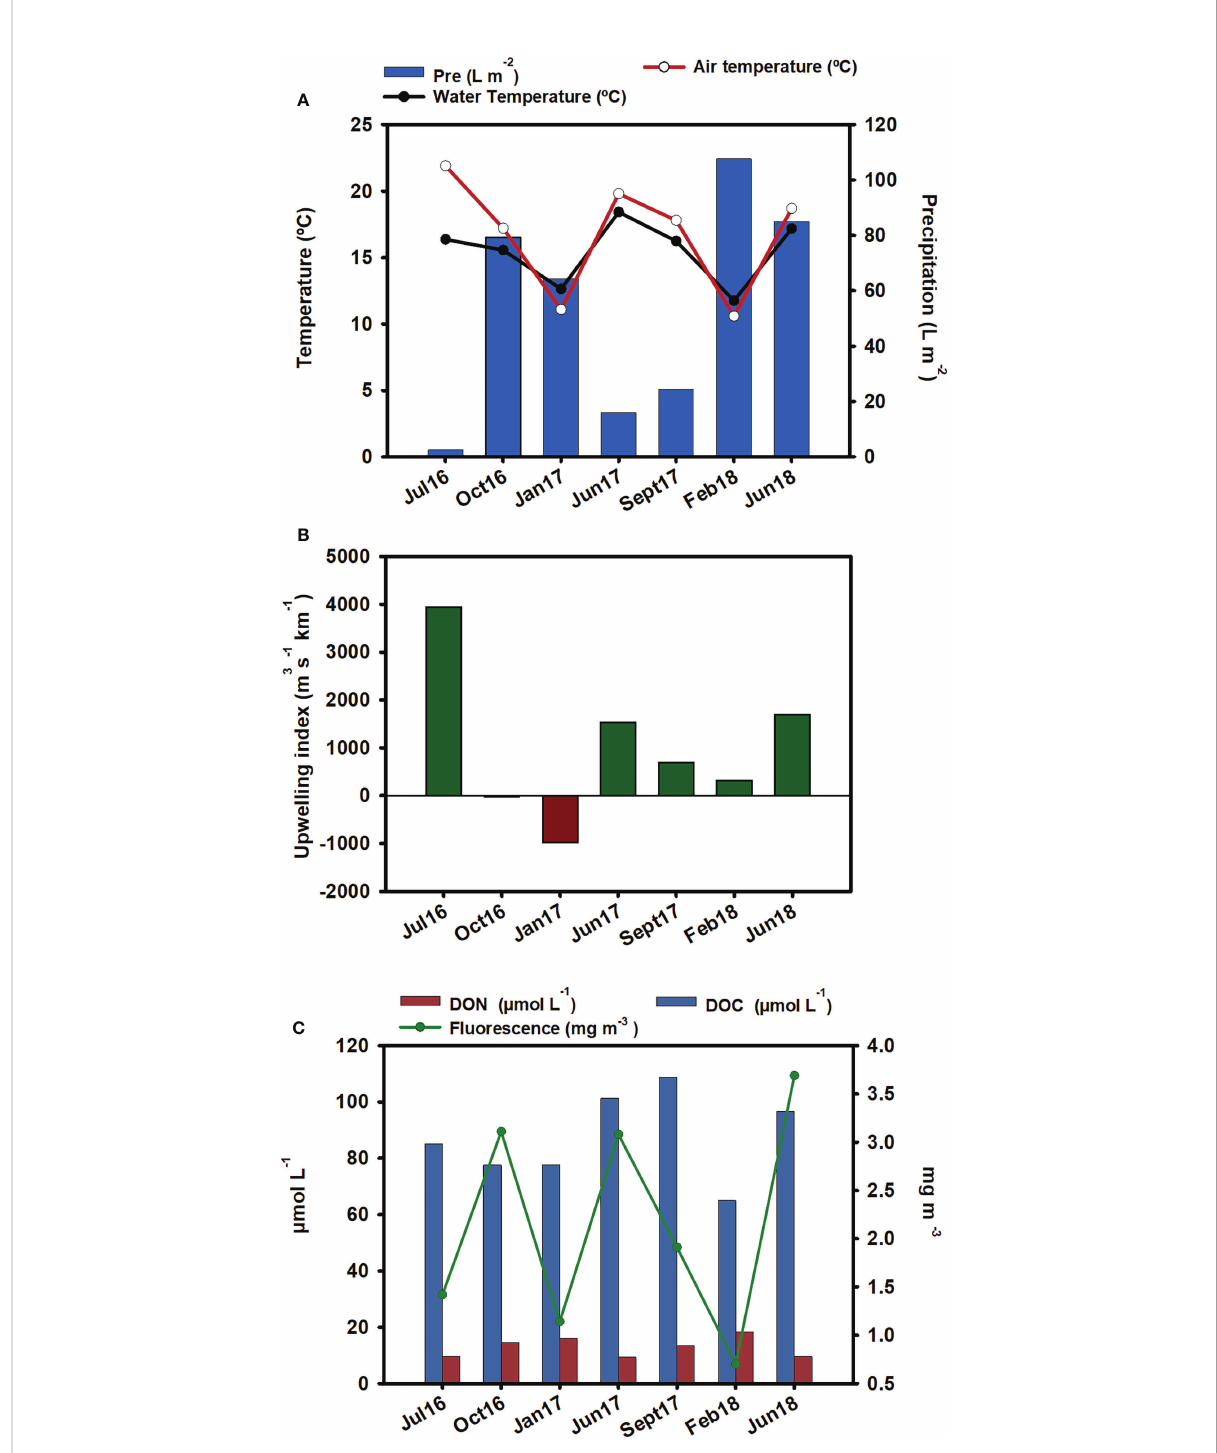
FIGURE 2 Environmental parameters: (A) precipitation (L m -2 ), water temperature (°C), and air temperature (°C). Data source: Meteogalicia (B) upwelling index. Data source: IEO. (C) DOC (µmol-L -1 ), DON (µmol-L -1 ), and fl uorescence (mg m -3 ) from the nearest station (V2 Moaña) to our samplings. Data source: Instituto Tecnolo ́ xico para o Control do Medio Mariño de Galicia